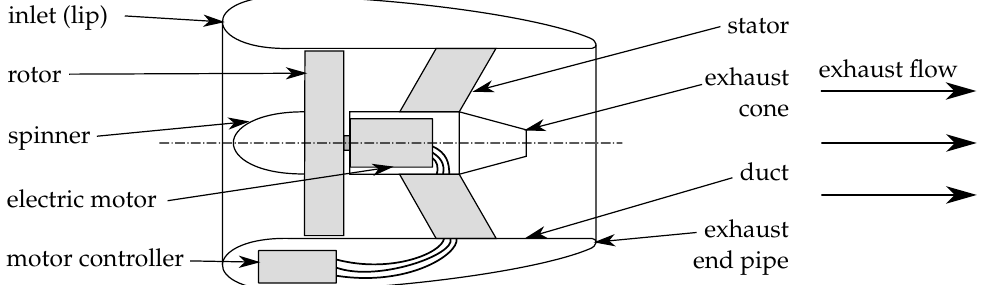
Figure 1. Visualization of components in a typical single-stage axial-flow EDF unit. Adapted from [5]. Similar types of electric aero-engines [6–10] have been studied for small-scale aircrafts